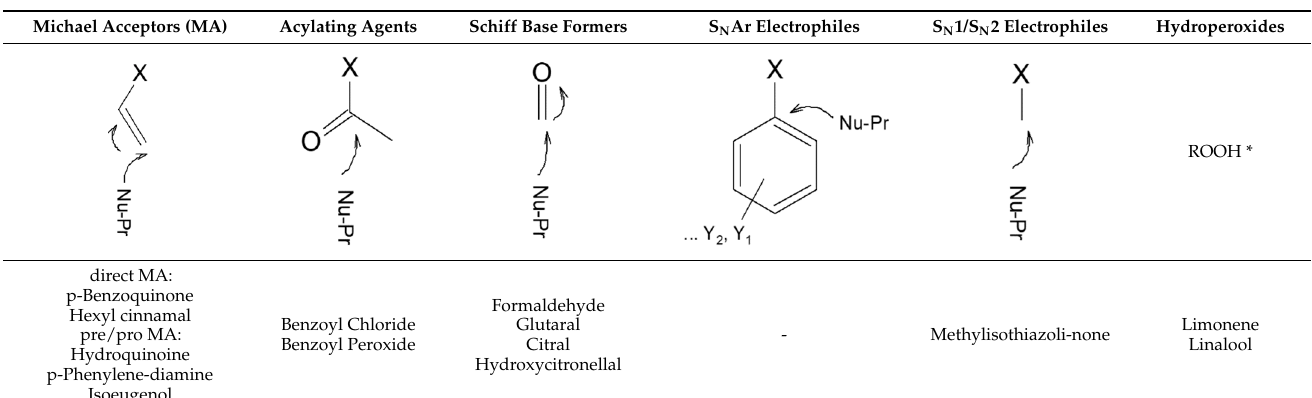
Table 3. The mechanistic domains for skin sensitization with cosmetics ingredient categorization examples.